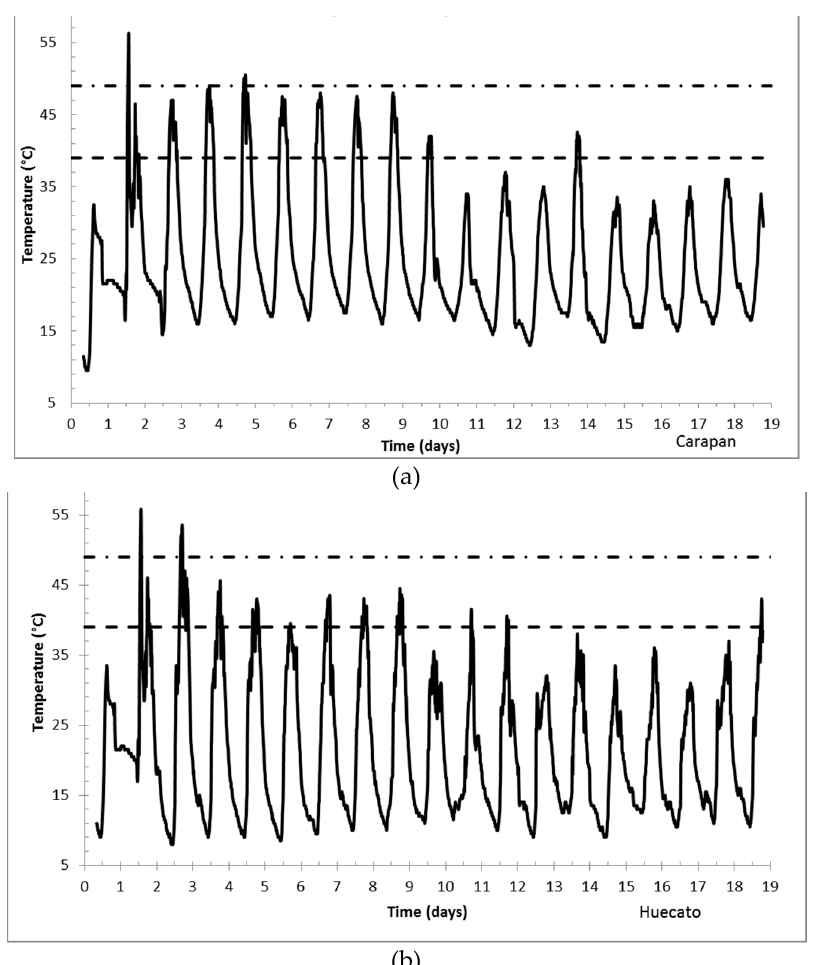
Figure 10. Temperature patterns recorded in Carapan ( a ) and Huecato ( b ). Peaks above the dashed line represent the case of the use of both modules; temperature peaks above the dotted / dashed line represent the use of the cooking module only.